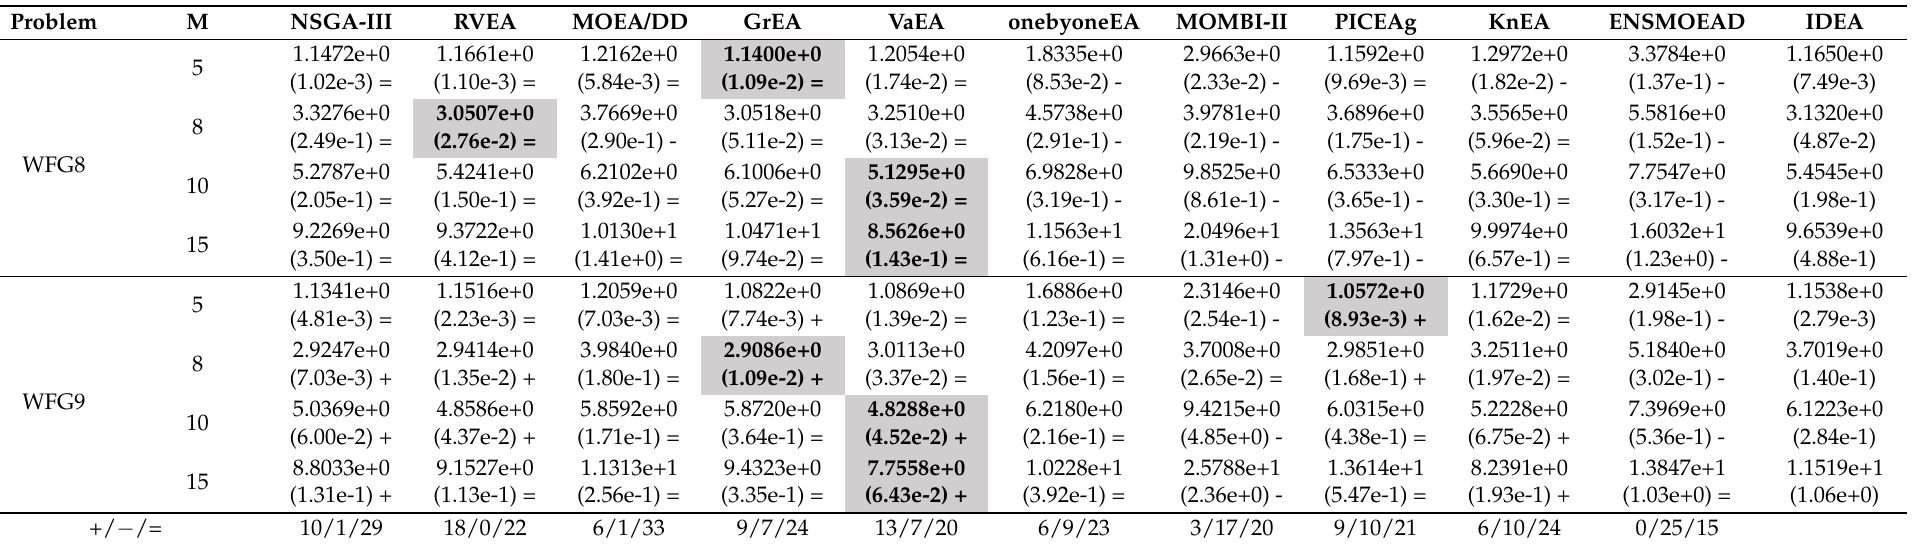
Values with a gray background and bold indicate the highest performing values. Table 4. The statistics of HV results (mean and standard deviation) on regular Pareto front